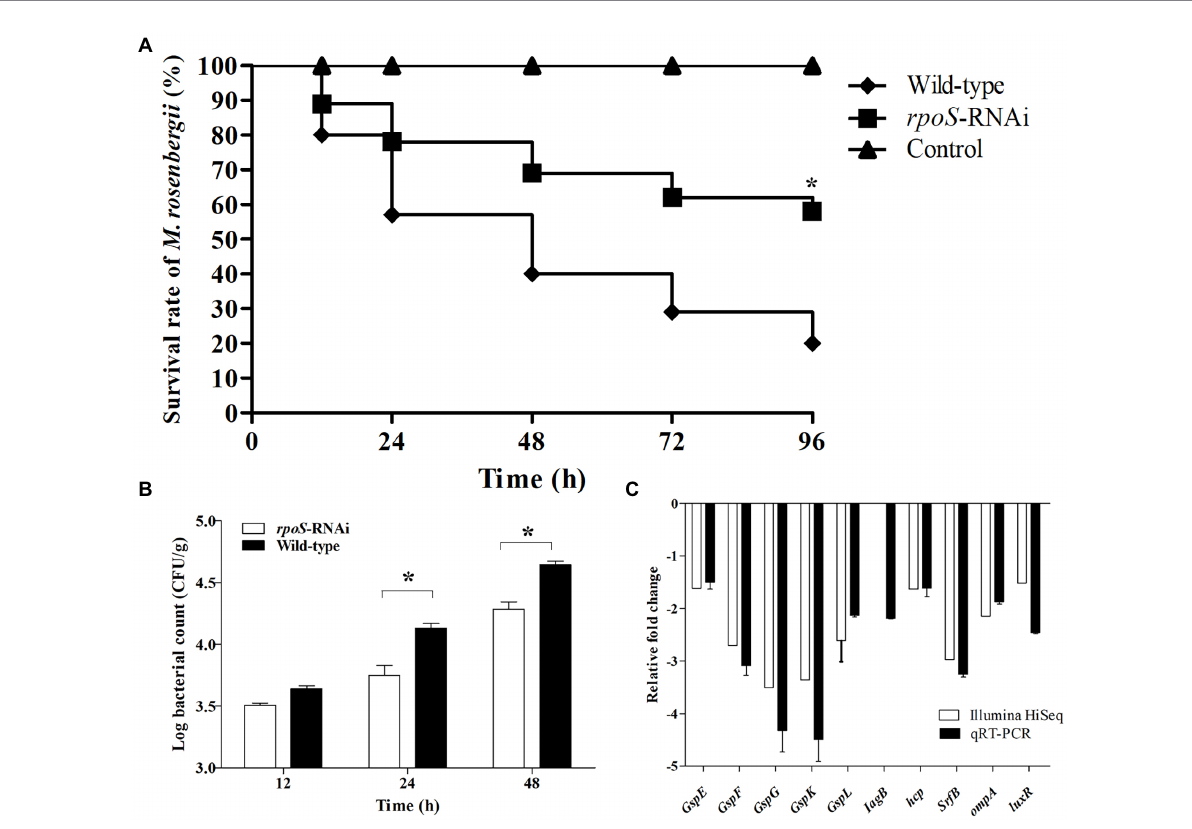
FIGURE 7 Effects of rpoS on virulence of Enterobacter cloacae. (A) Survival of M. rosenbergii after infected with E. cloacae wild-type and rpoS -RNAi strains; (B) Bacterial burden of M. rosenbergii after infected with E. cloacae wild-type and rpoS -RNAi strains; (C) Expressions of virulence-related genes in rpoS -RNAi strain; The asterisk indicated significant differences between the E. cloacae wild-type and rpoS -RNAi infected groups ( p <